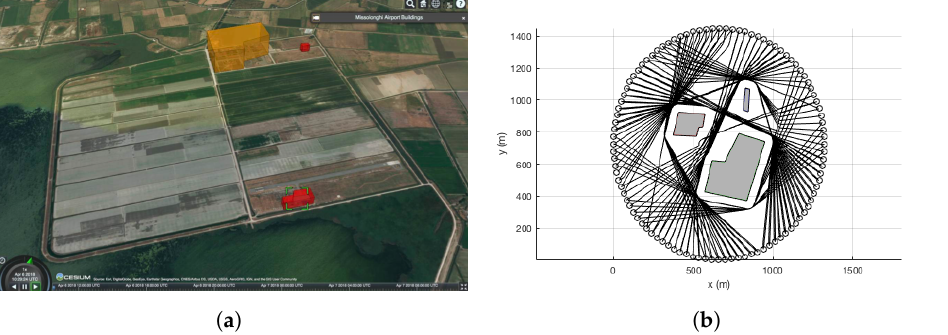
Figure 4. Simulation scenario. ( a ) Test site, Messolonghi Airport in Greece. ( b ) Simulation